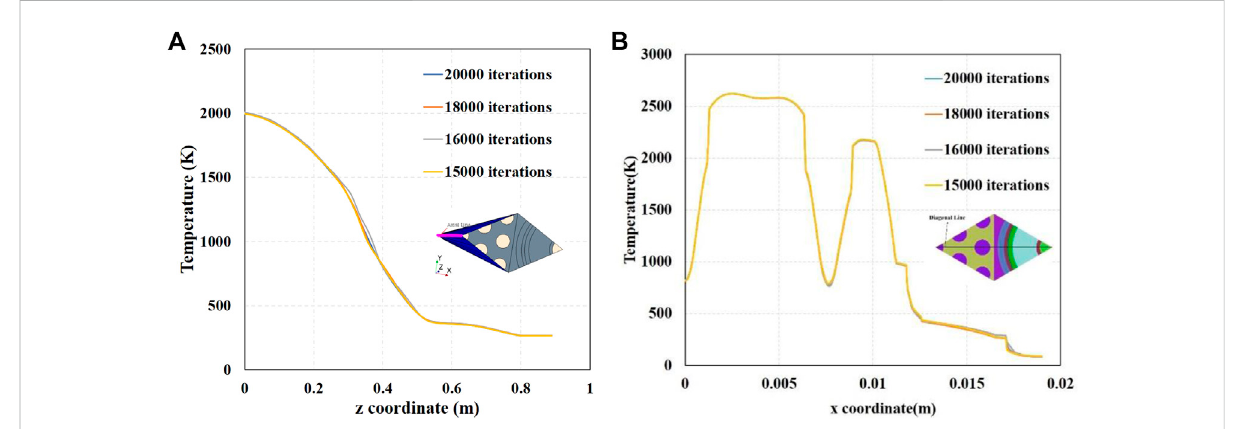
FIGURE 5 Temperature versus iterations. (A) axial distribution. (B) radial distribution.